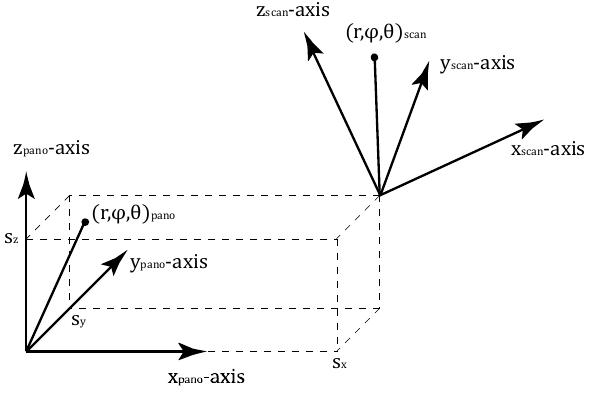
Figure 7. Relations between scanner and panoramic spherical coordinate